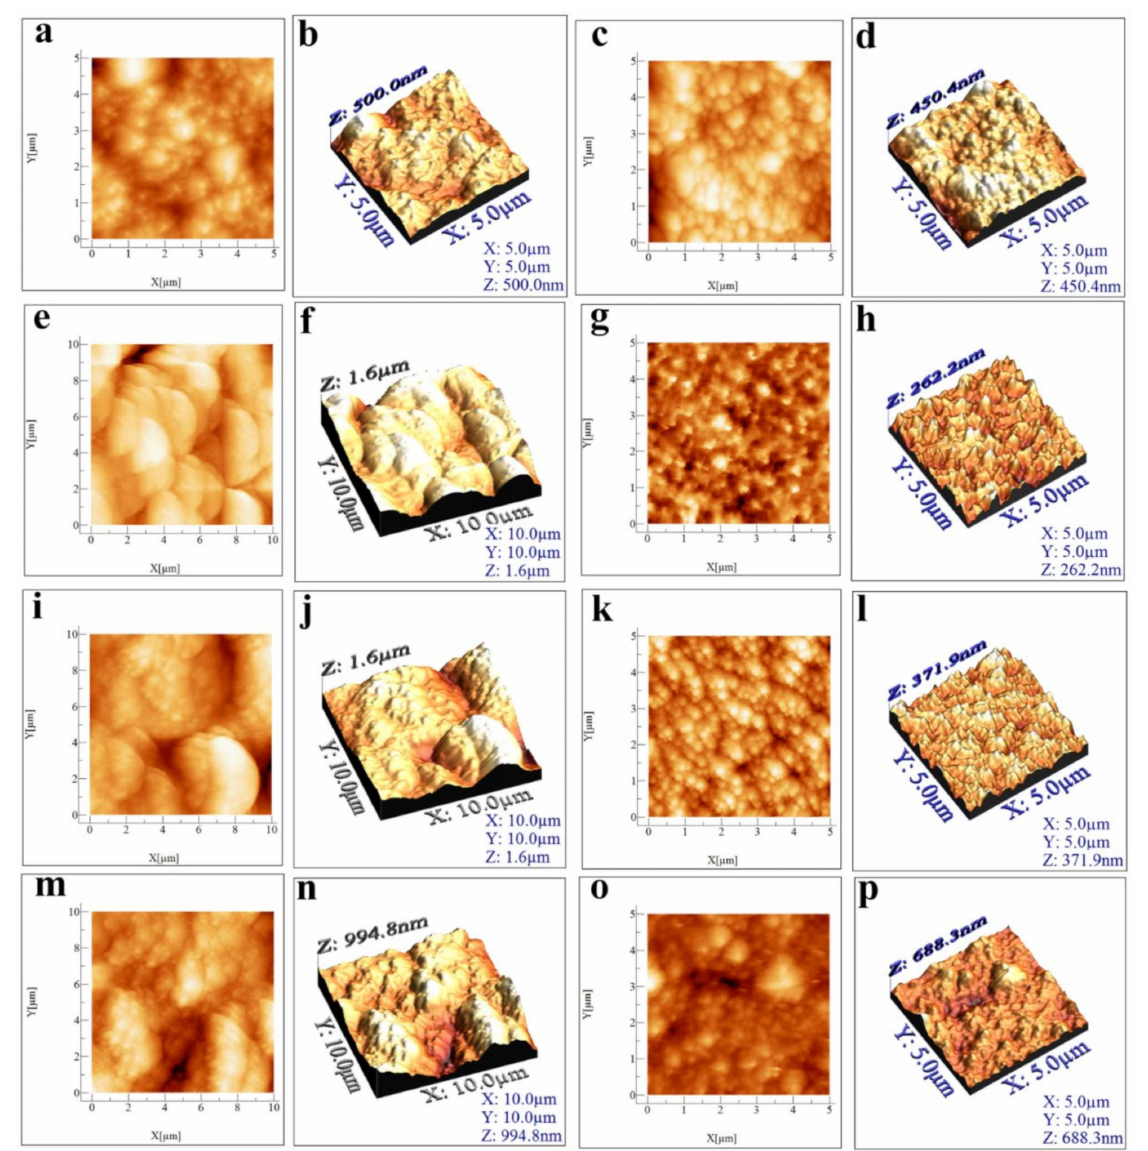
Figure 9. 2D AFM micrographs recorded for the HA13 ( a ), HA3 ( c ), HA14 ( e ), HA15 ( g ), HA16 ( i ), HA17 ( k ), HA18 ( m ), and HA19 ( o ) samples and their respective 3D representations ( b , d , f , h , j , l , n , p